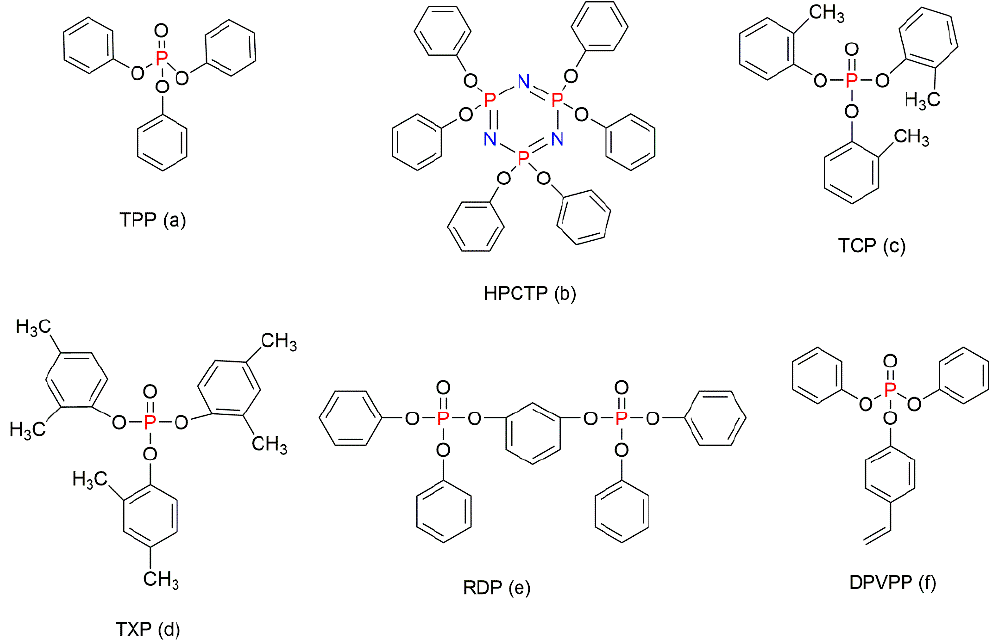
Figure 14. Chemical structures of different P-containing additive FRs [87–89].